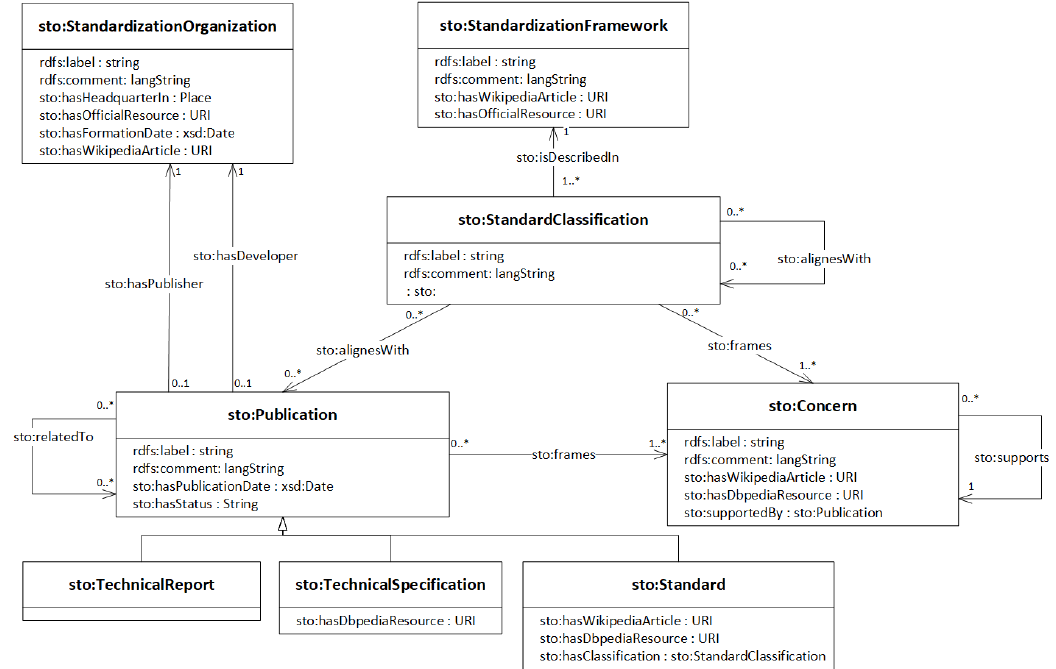
Figure 2. Structure of the IIoT knowledge graph. The original scheme [19] is extended by the set of concerns and architecture